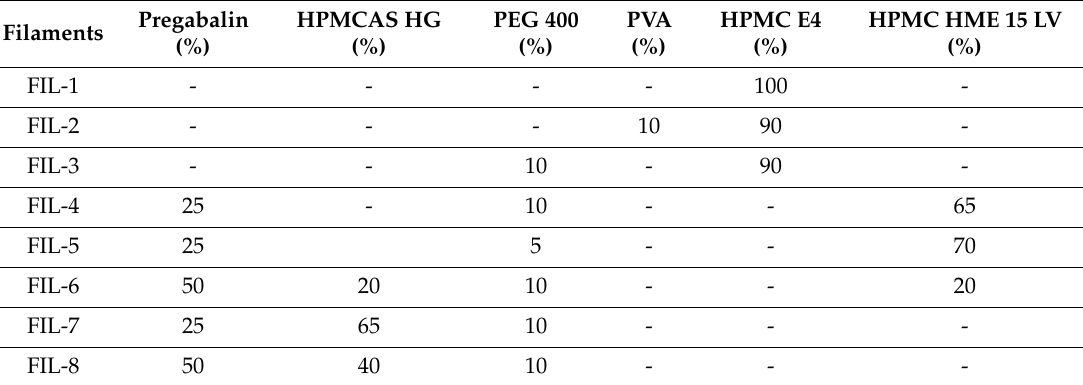
Table 1. Composition of filaments prepared.